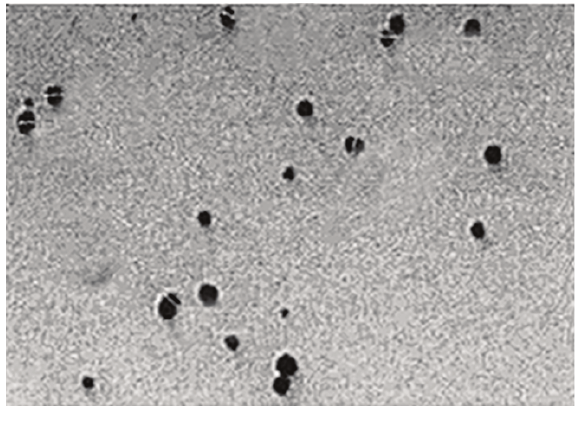
group: (ad) at 3rd day. P(I): significant difference between different experimental groups within the same interval. P value < 0.01 was considered highly significant.